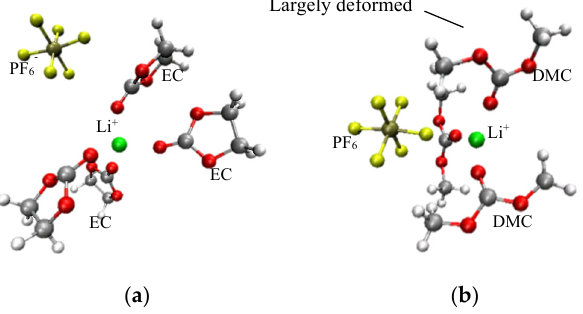
Largely deformed